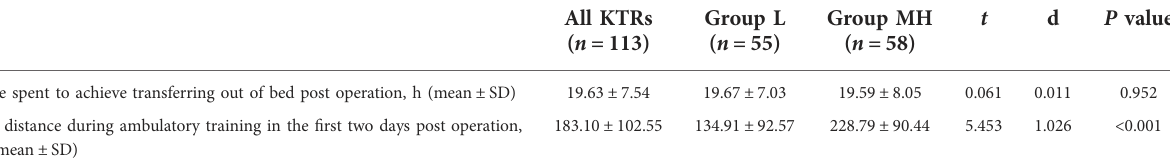
TABLE 2 Postoperative mobilization of KTRs ( n =113).